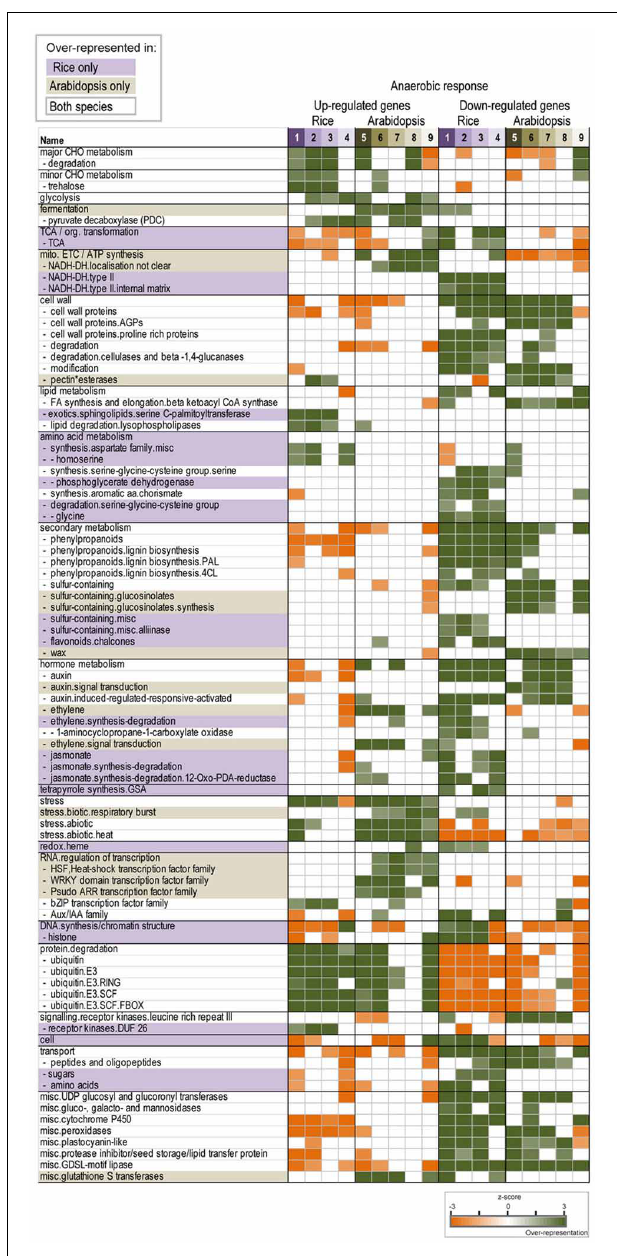
FIGURE 3 | Defining the core low oxygen response. Pageman over-representation analysis was carried out for the significantly differentially expressed genesets ( > 2-fold, p < 0 . 05, PPDE > 0.96) in response to low oxygen in rice and Arabidopsis. The gene sets used included four different comparisons in rice and five different comparisons in Arabidopsis of control vs. anaerobic treatment (details in Table 1 ). Only the functional categories over-represented in rice only, Arabidopsis only or both species are shown ( z -scores indicate over/under-representation, indicated by the green/yellow colors,